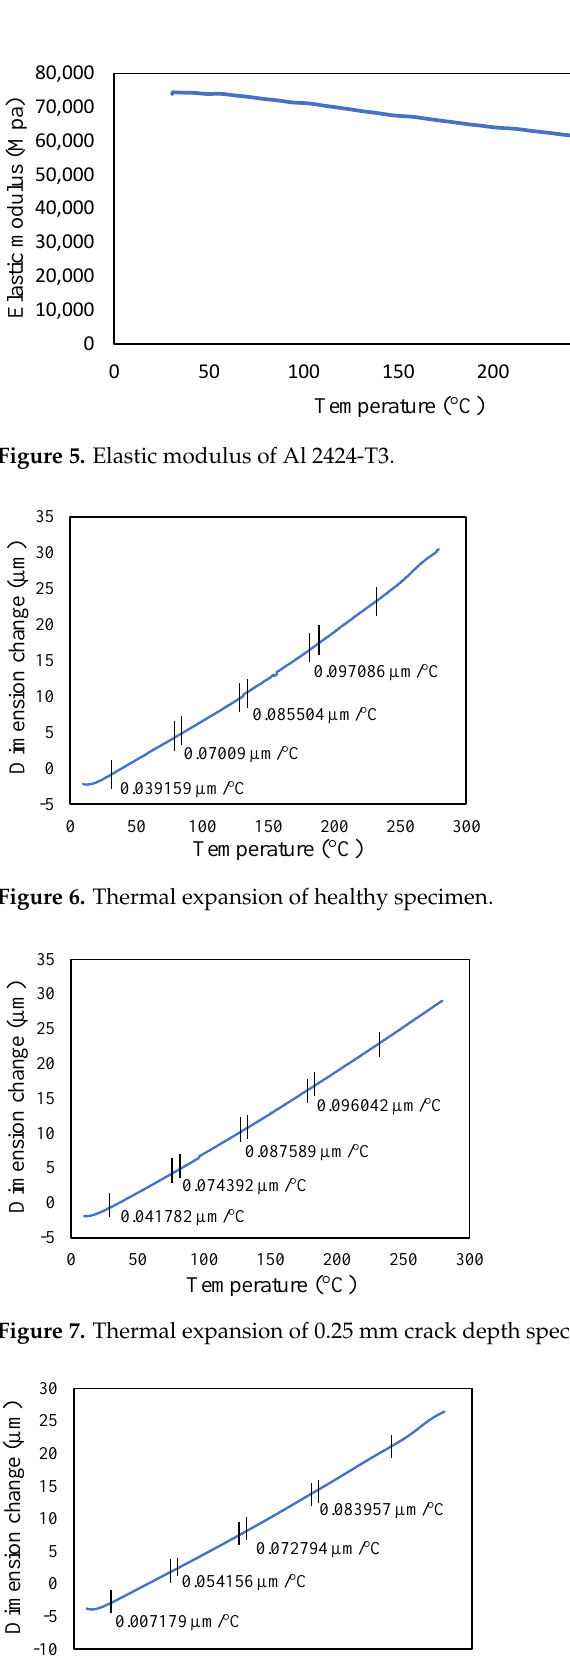
Figure 9. Thermal expansion of 1 mm crack depth specimen. The thermal expansions were measured without crack and with crack conditions. It was noticed that the coefficient of thermal expansion is increased from 0.039 to 0.097 µm/°C in the case of without cracks. However, in 0.25 mm crack depth it increases from 0.041 to 0.096 µm/°C while, in 0.5 mm it rises from 0.0071 to 0.083957 µm/°C and 0.1 mm crack depths start from − 0.031 to 0.073 µm/°C. Therefore, the coefficient of thermal expansion is not uniform in all cases. Comparatively, the greater temperature has higher thermal expansion per degree Celsius than lower temperature. This indicates that the thermal expansion increases linearly with an increase in temperature, but with a different rate and crack conditions. 3.2. Thermal and Elastic Strain Intensity Analysis